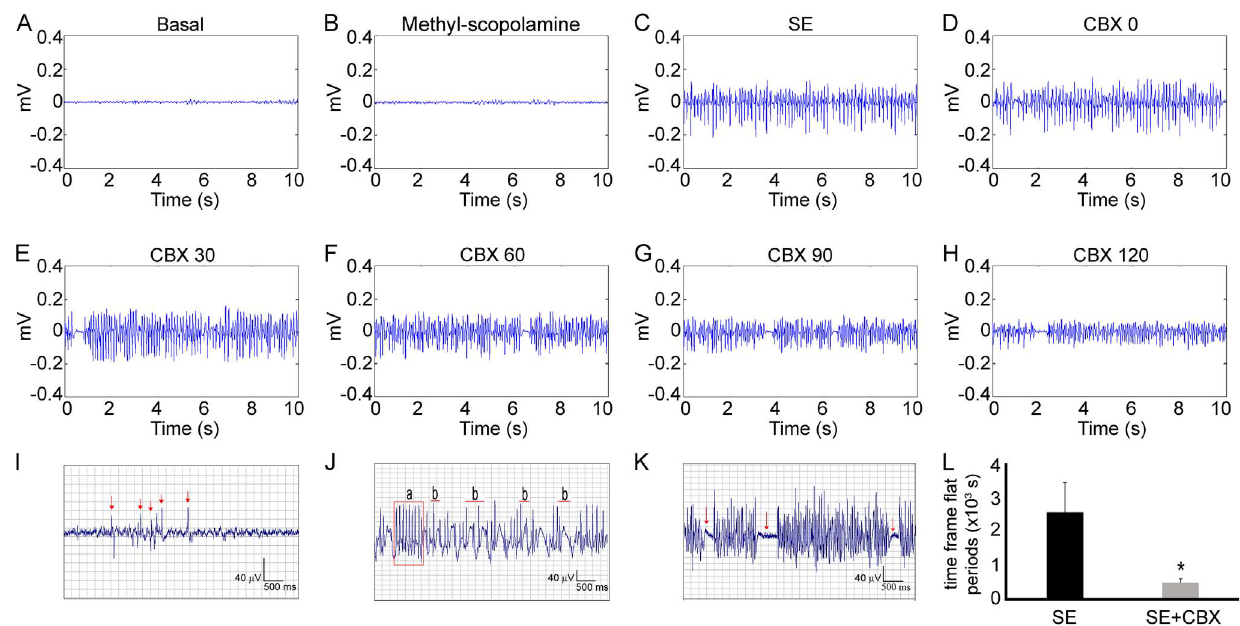
Figure 1. Effects of pharmacological blockade of GJ channels on ECoG. Representative local field potentials of SE + CBX group. (A, B) It is possible to see that basal and methyl-scopolamine periods share similar electrical activity patterns. After pilocarpine injection, we observed increasing epileptiform potentials represented by isolated spikes (I, arrows), poly-spikes (J-a) and spike-wave complexes (J-b), culminating in SE establishment (C). CBX administration 30 minutes after SE establishment (D) was able to induce changes in the epileptiform potentials, which could be seen during the whole analyzed interval post-CBX injection (E–H). We found out that the time frame for occurrence of flat periods (K, arrows) from SE + CBX group was significantly shorter when compared to SE group (L). Bars represent standard errors of mean. * P , 0.01 in